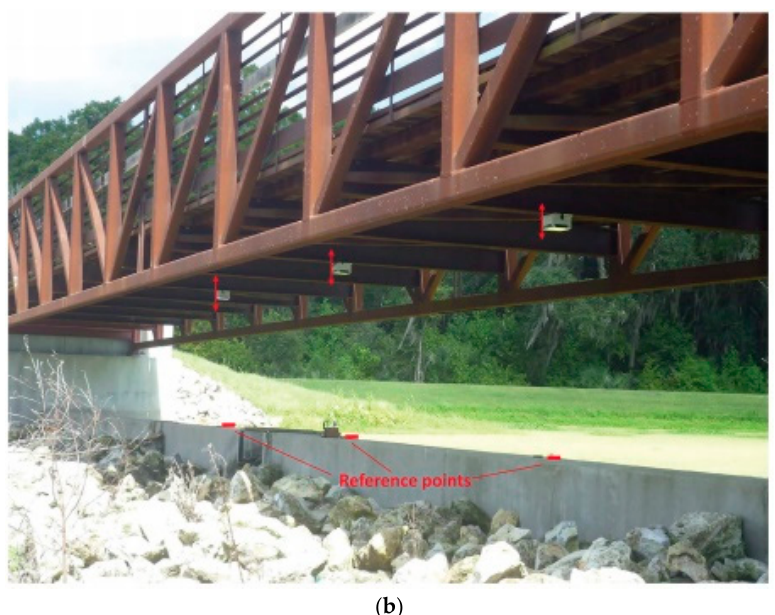
Figure 4. Experimental setup for the SHM of a bridge done by a Doppler radar sensor network: ( a ) Doppler radar mounted on plastic enclosure; ( b ) Doppler radar network deployed. Reprinted with permission from ref. [69]. Copyright 2018 American Society of Civil Engineers .